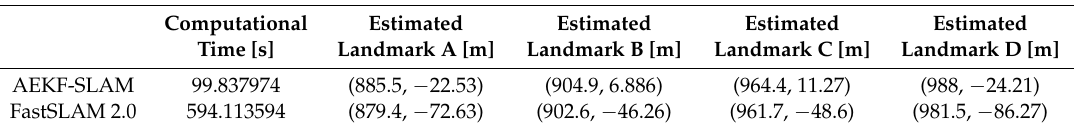
Table 5. The comparisons of the computational time and estimated the landmark A, B, C, D positions in the line map derived by the AEKF-SLAM and FastSLAM